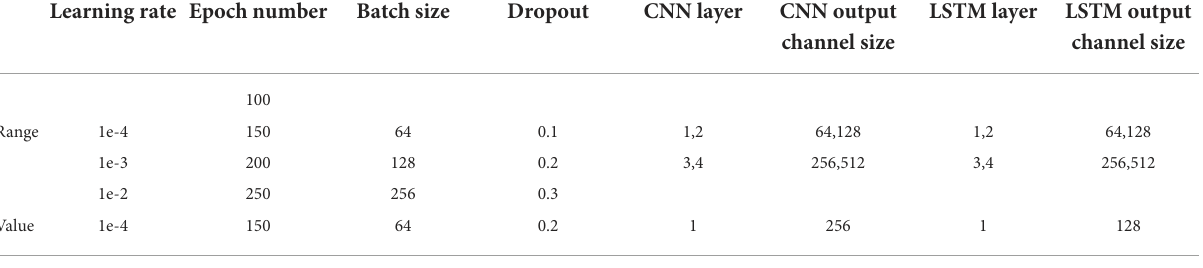
TABLE 2 Network structure and training hyperparameters tuning.